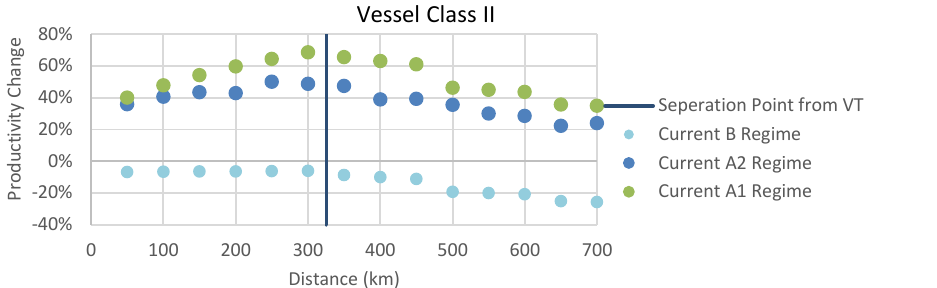
Figure 5: Productivity Change Plot For Vessel Class